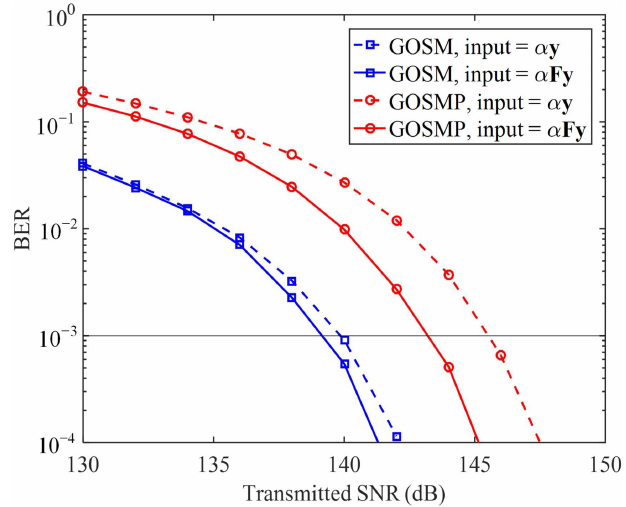
Figure 6. BER comparison of the proposed CSI-free DNN detector where the feedforward DNN module having different inputs for both GOSM and GOSMP at the center of the receiving